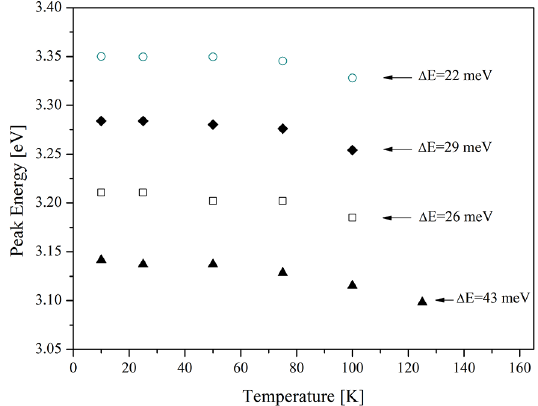
Figure 9. Position of the PL zero phonon line, ZPL, and phonon replica as a function of temperature for the GaN film, at the second focusing point.